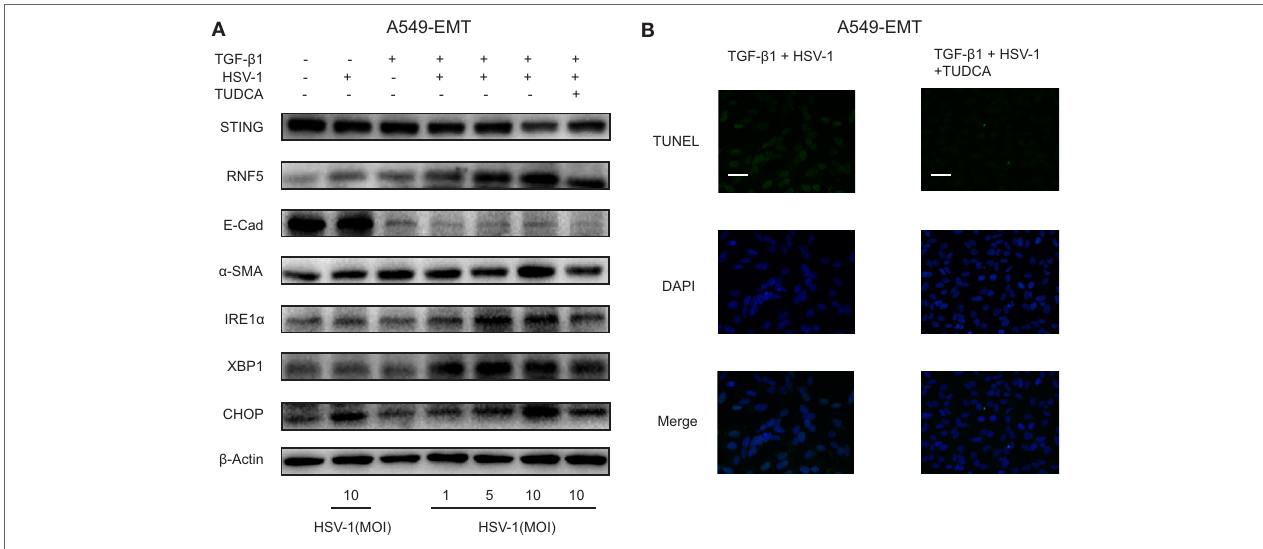
FigUre 5 | Herpes simplex virus type 1 (HSV-1) infection induced endoplasmic reticulum stress and downregulated stimulator of interferon genes (STING) protein expression in A549-EMT cells. (a) Representative Western blot image of the protein expression of STING, RNF5, E-Cad, α -SMA, inositol-requiring enzyme 1 α (IRE1 α ), X-box protein 1 (XBP1), and C/EBP homologous protein (CHOP) in A549 cells treated with herpes simplex virus type 1 (HSV-1) (MOI 0, 1, 5, or 10) for 6 h and transforming growth factor- β 1 (TGF- β 1) (5 ng/mL) for 48 h to induce epithelial–mesenchymal transition (EMT). A549 cells were treated with tauroursodeoxycholic acid (TUDCA) (500 µg/mL) prior to HSV-1 infection. Western blot was repeated for three times and the three experiments showed similar results. (B) Representative immunofluorescence staining for TUNEL assay of A549 cells treated with TGF- β 1 and HSV-1. Magnification: × 400; scale bars represent 20 µm. Abbreviation: E-cad,